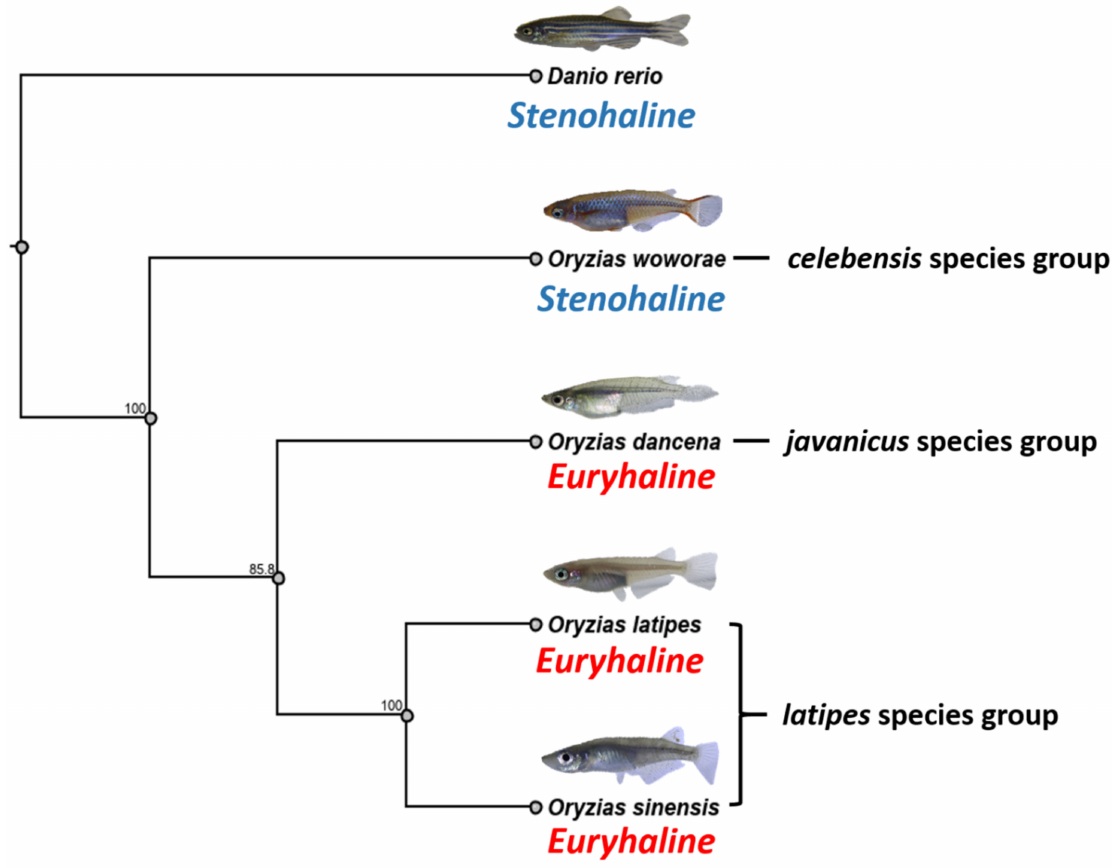
Figure 7. Phylogenetic relationships among four Oryzias species and Danio rerio inferred from the datasets of NADH dehydrogenase subunit 2 gene ( nd2 ). The phylogenetic relationships were analyzed by the maximum likelihood method. The numbers beside the branches indicate the bootstrap values. Based on the prior publication by Murata et al. (2019), O. latipes and O. sinensis genetically belong to the latipes species group while O. dancena and O. woworae belong to javanicus and celebensis species groups,